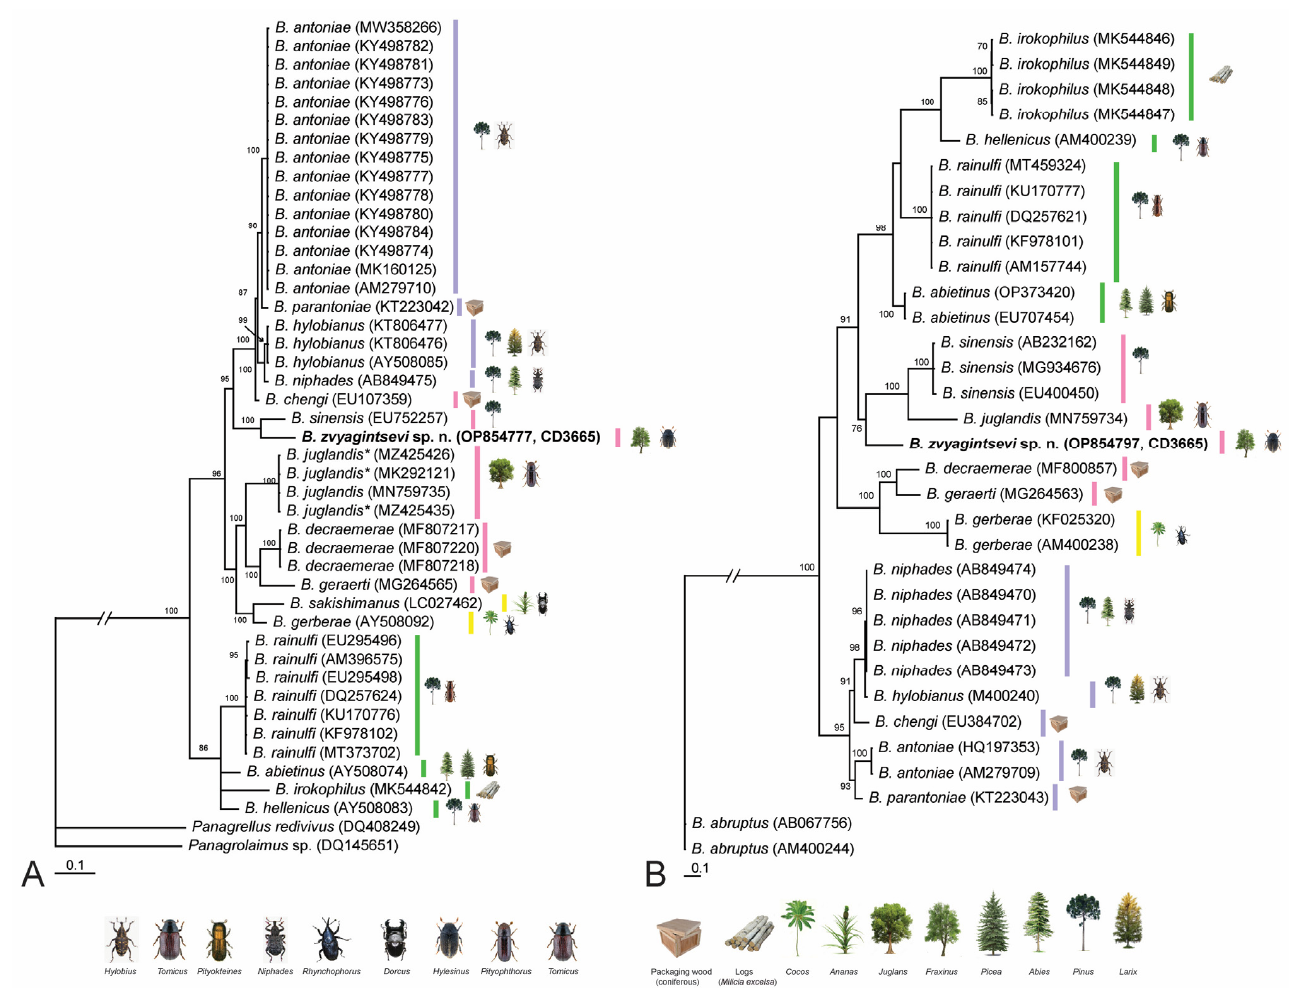
Figure 4. Phylogenetic relationships of Bursaphelenchus zvyagintsevi sp. n. within some species of the Abietinus group sensu , Ryss et al. [32], as inferred from Bayesian analysis of the D2–D3 of 28S rRNA (ntax = 45 nchar = 820) ( A ) and ITS rRNA (ntax = 33 nchar = 1356) ( B ) gene sequences. Posterior probability values more than 70% are given on appropriate clades. New sequence is indicated in